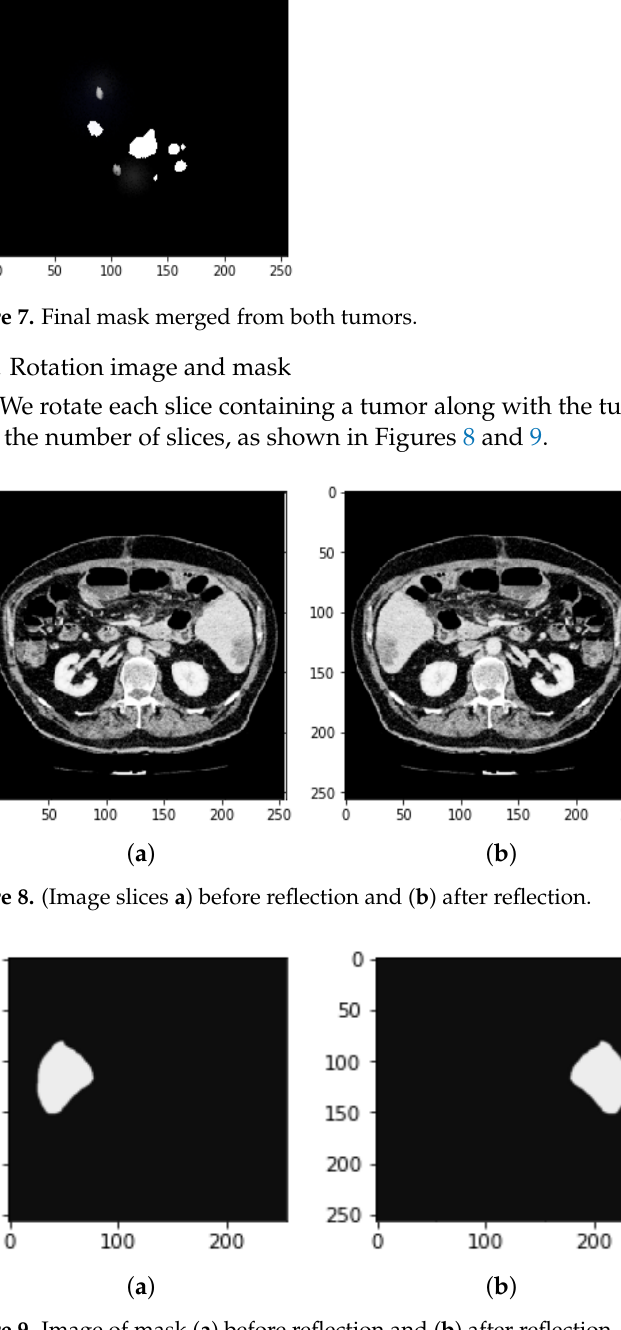
Figure 9. Image of mask ( a ) before reflection and ( b ) after